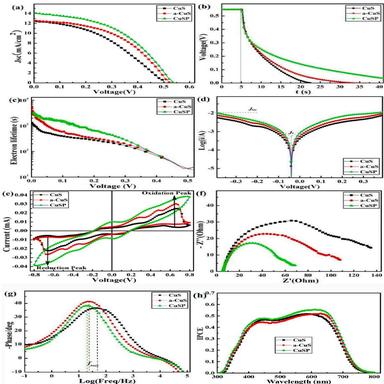
(a) J-V and (b) OCVD for QDSSCs with different CEs. (c) τn obtained from OCVD. (d) Tafel, (e) CV and EIS (f, g) of the symmetric cells. (h) IPCE for QDSSCs with different CEs.